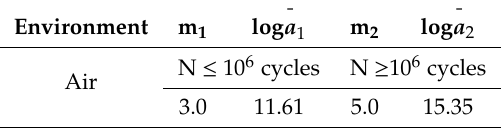
Table 6. S-N curves for tower and pile (Structural detail class E).